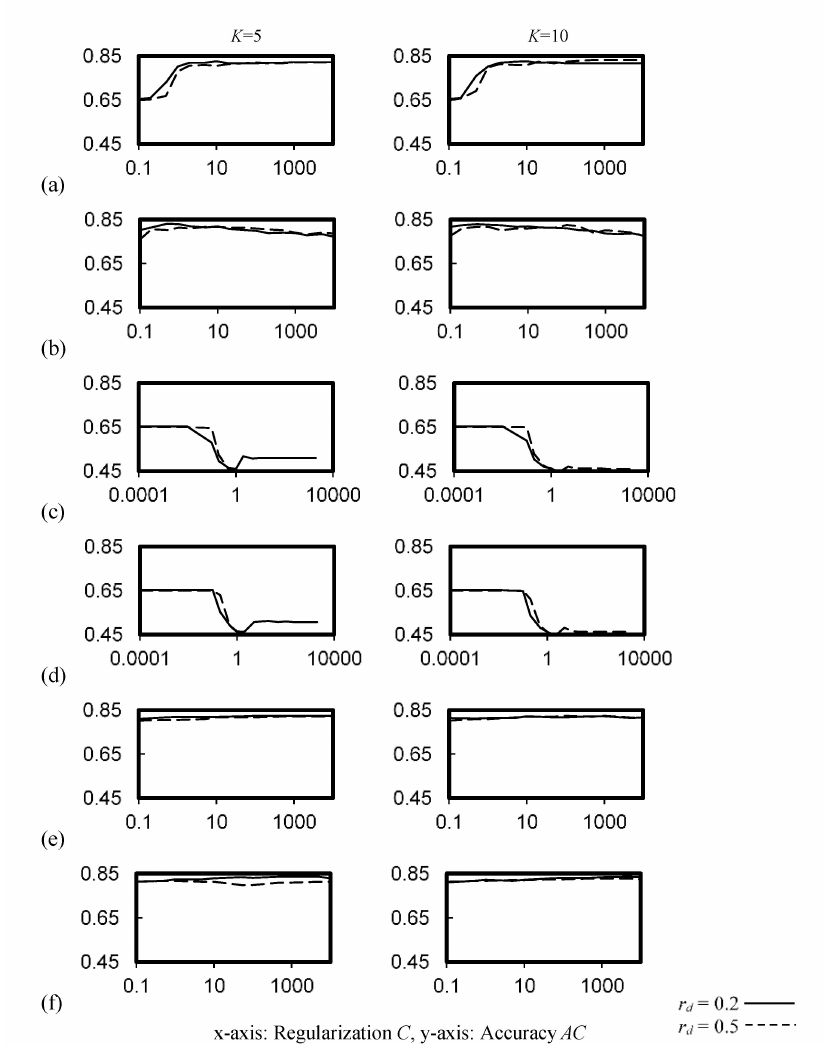
Figure 3. Cross-validation accuracy of the SVM classifier. ( a ) Linear kernel, ( b ) rbf kernel, ( c ) sigmoid kernel, c 0 = 0.01, ( d ) sigmoid kernel, c 0 = 0.5, ( e ) polynomial kernel, c 0 = 0, c 1 = 2, ( f ) polynomial kernel, c 0 = 1, c 1 =